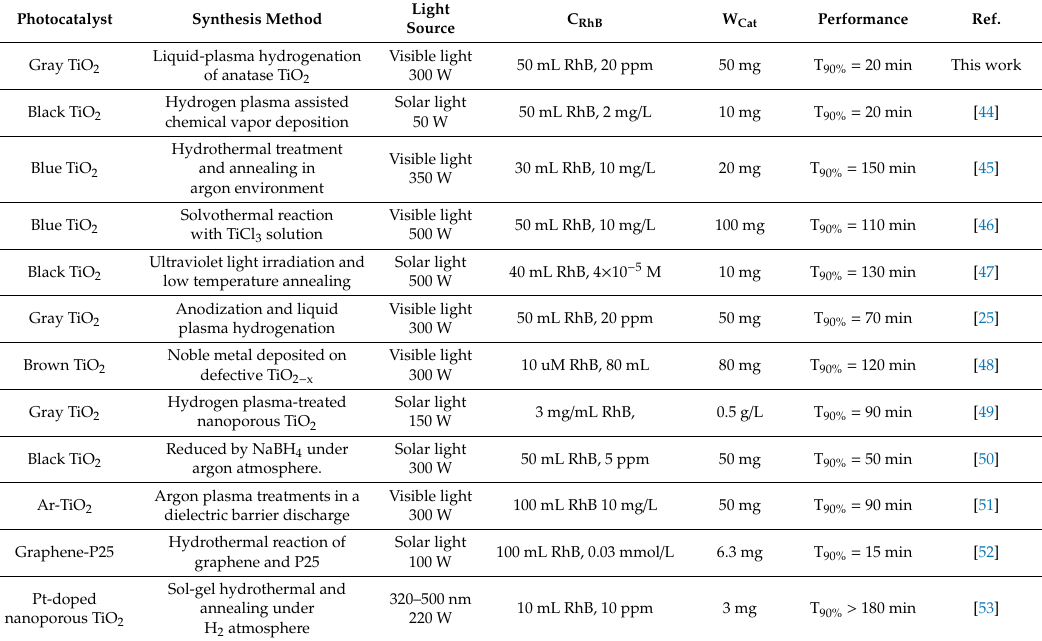
Table 1. Comparison of rhodamine B photodegradation e ffi ciency over gray TiO 2 − x with reported colored titania and highly e ffi cient